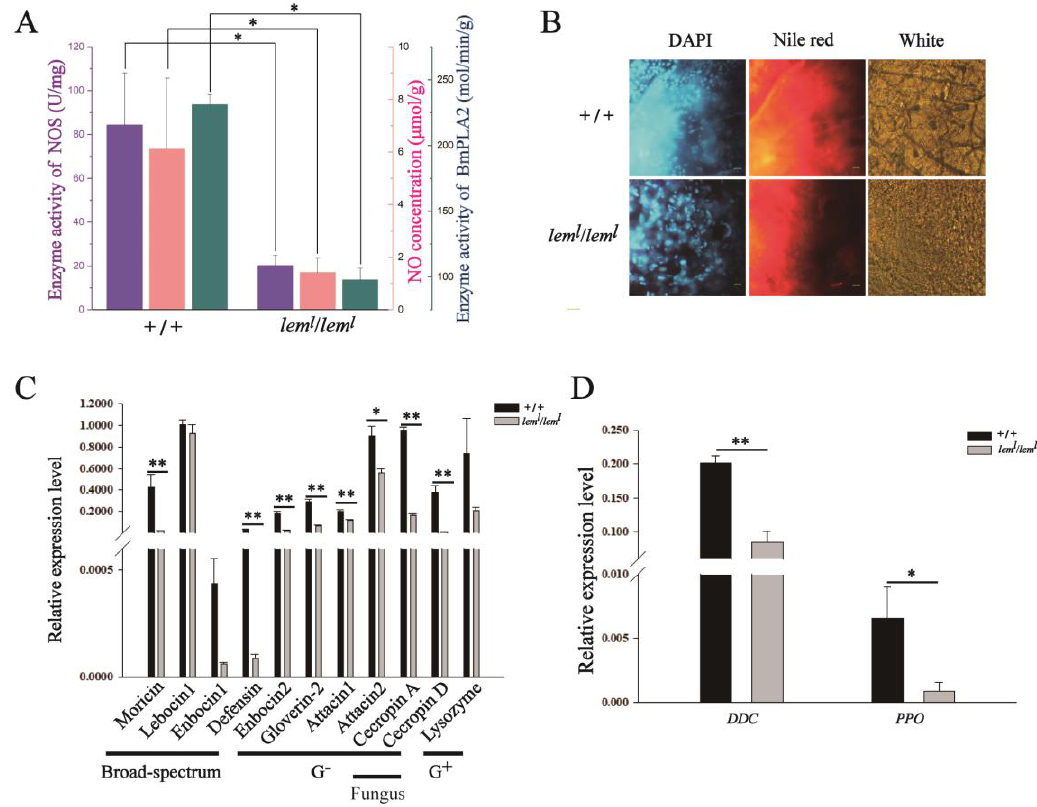
Figure 3. Decrease in NOS enzyme activity led to the decrease of NO, which damaged the immune system in lem l homozygotes. ( A ) NOS (represented by blue columns) and PLA2 enzyme activities (represented by pink columns) decreased, and NO content (represented by green columns) decreased in lem l . ( B ) The content of liposomal lipids in lem l . The scale bar in the lower right corner represents 200 µ m. ( C ) The expression level of antimicrobial peptides in lem l . The detected genes included anti-Galanz positive bacteria gene, anti-Galanz negative bacteria genes, anti-broad-spectrum antibacterial genes and anti-fungal genes, which were represented by G + , G − , broad-spectrum and fungus in the figure, respectively. ( D ) Expression level of cellular immune genes in lem l . All materials were from second-instar lem l homozygous mutants. The accession numbers of genes and proteins involved in the figure are shown in Table 1. Data are mean values ± S.E.M ( n = 3). Error bars represent mean ± SD; * p < 0.05; ** p <